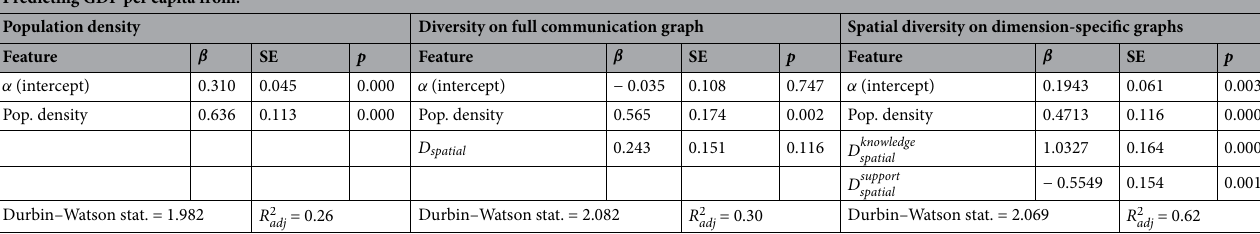
Table 1. Linear regressions to predict GDP per capita of US states from: (left) population density only; (center) spatial diversity computed on the full communication graph; (right) spatial diversity computed on dimension-specific communication graphs. Population density is added as a control variable in the latter 2 two models. Adjusted R and Durbin–Watson statistic for autocorrelation (values close to 2 indicate no autocorrelation) are reported. The contribution of individual features to the models is described by their beta - coefficients, standard errors (SE) and p